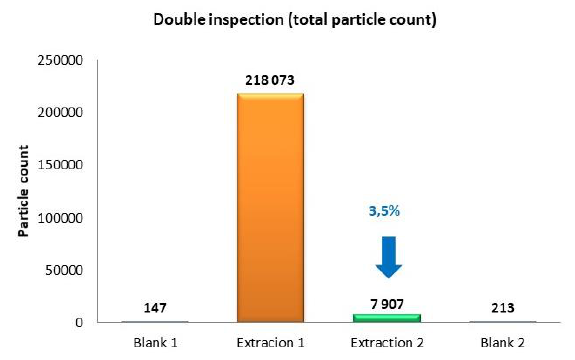
Fig. 9. Example of double inspection